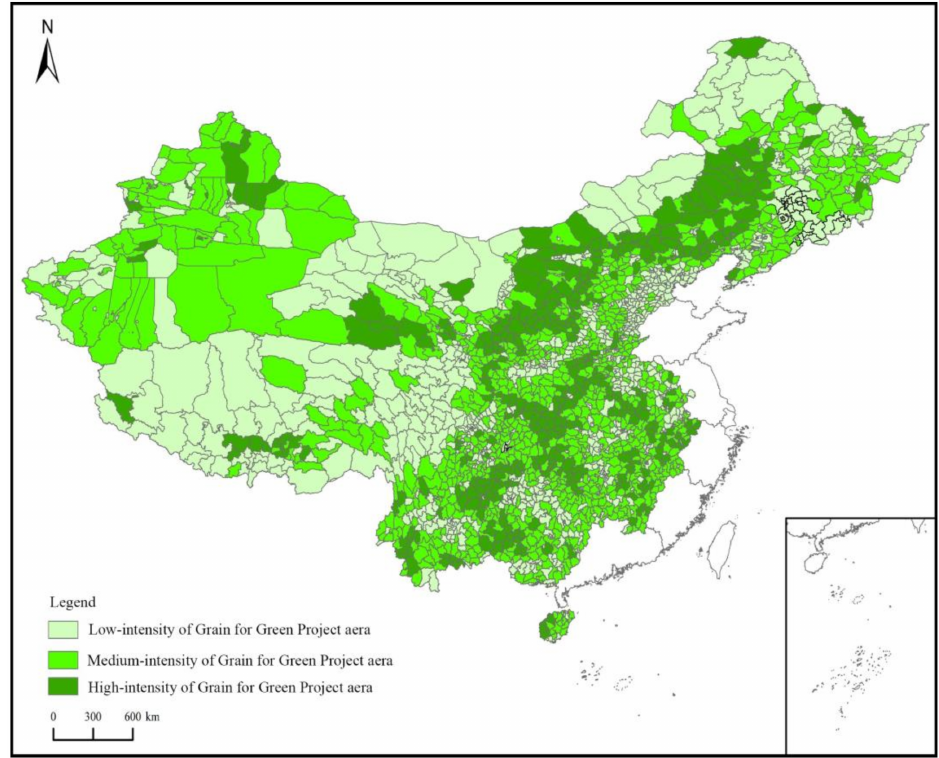
Figure 2. Implementation intensity of the Grain for Green